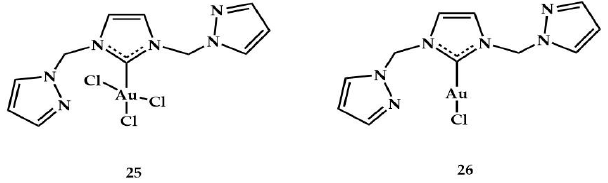
Figure 11. Au(III) and Au(I) complexes synthesized by Messerle et al. [27]. Table 8 . Intramolecular hydroamination reaction.